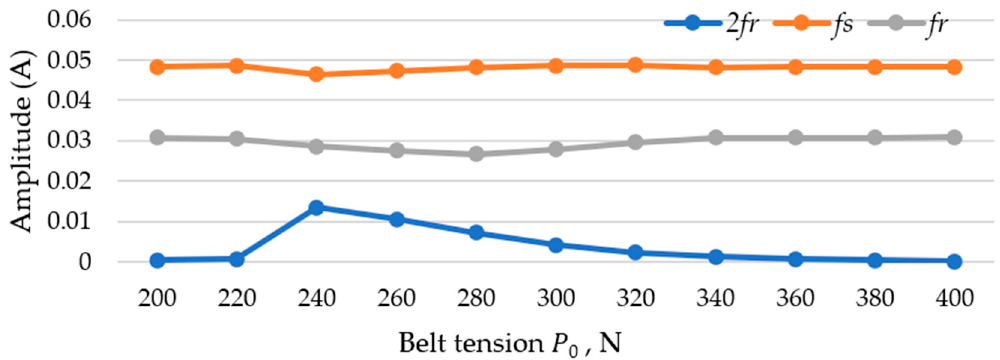
Figure 13. Amplitudes at 2 f r , f s , and f r with changes in belt tension, P 0 .